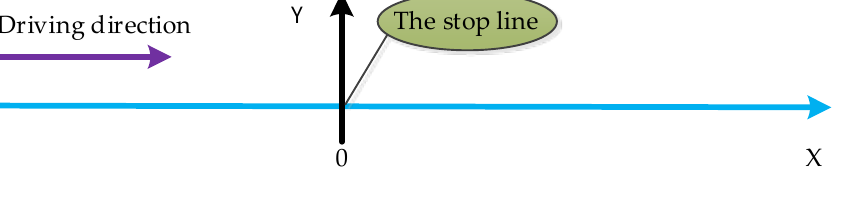
Figure 4. Intersection coordinates.